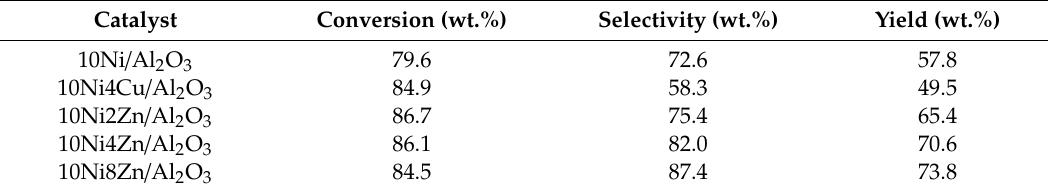
Table 1. The catalytic performance of all